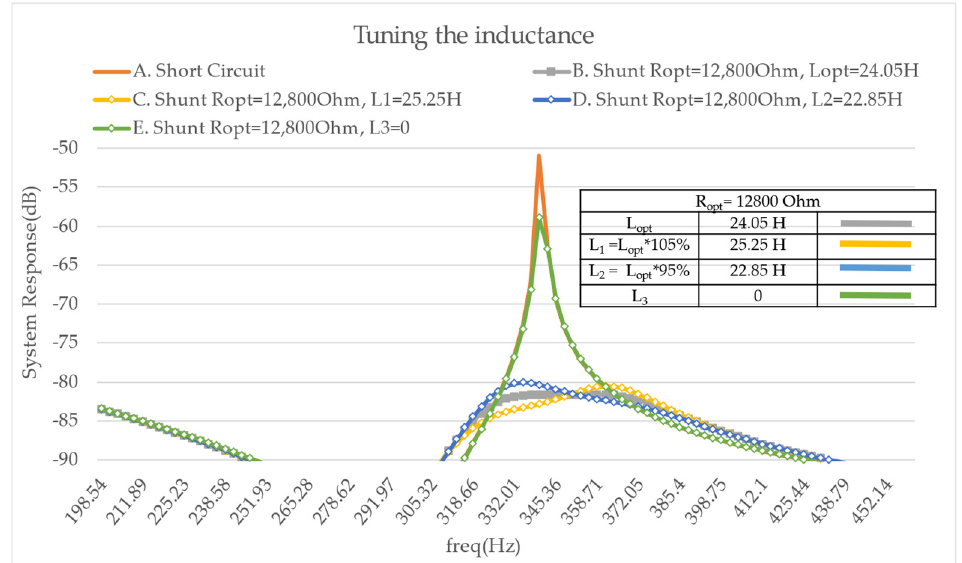
Figure 9. FRF Modulus on mode 2 — tuning the inductance — A. with a short circuit, B. with the optimal resistance and inductance, C. with 105% of the optimal inductance, D. with 95% of the optimal inductance, E. with the optimal resistance and no inductance.